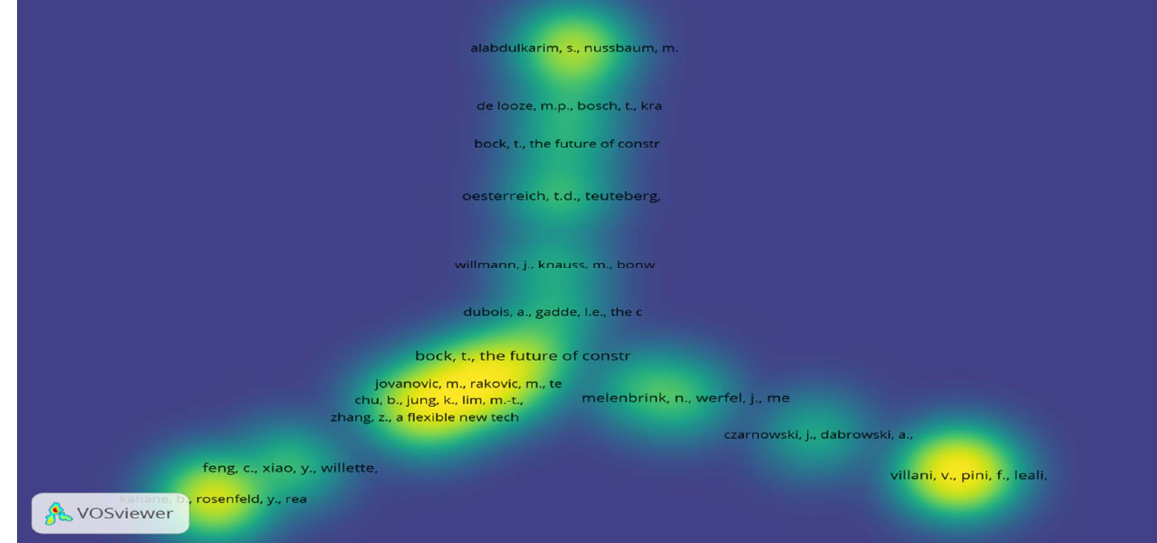
Figure 3. Most-cited publications.